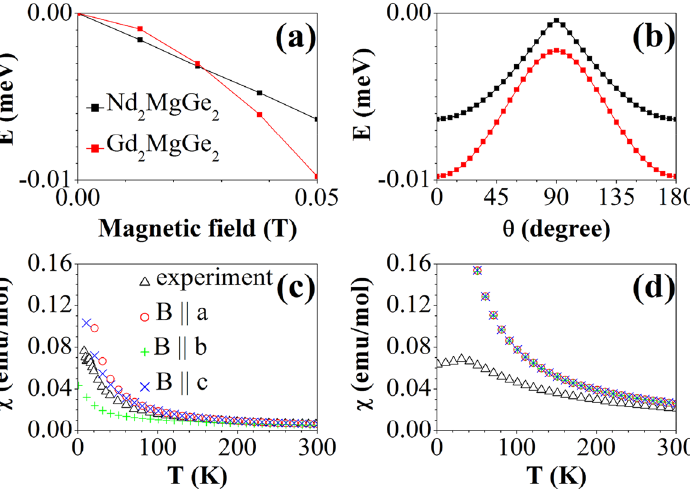
Figure 5. Dependence of the lowest ground state multiplet energy on the ( a ) strength of an external magnetic field within the ab -plane and ( b ) angle of a 0.05 T magnetic field with respect to the a -axis. Temperature dependence of the magnetic susceptibility for ( c ) Nd 2 MgGe 2 and ( d ) Gd 2 MgGe 2 .